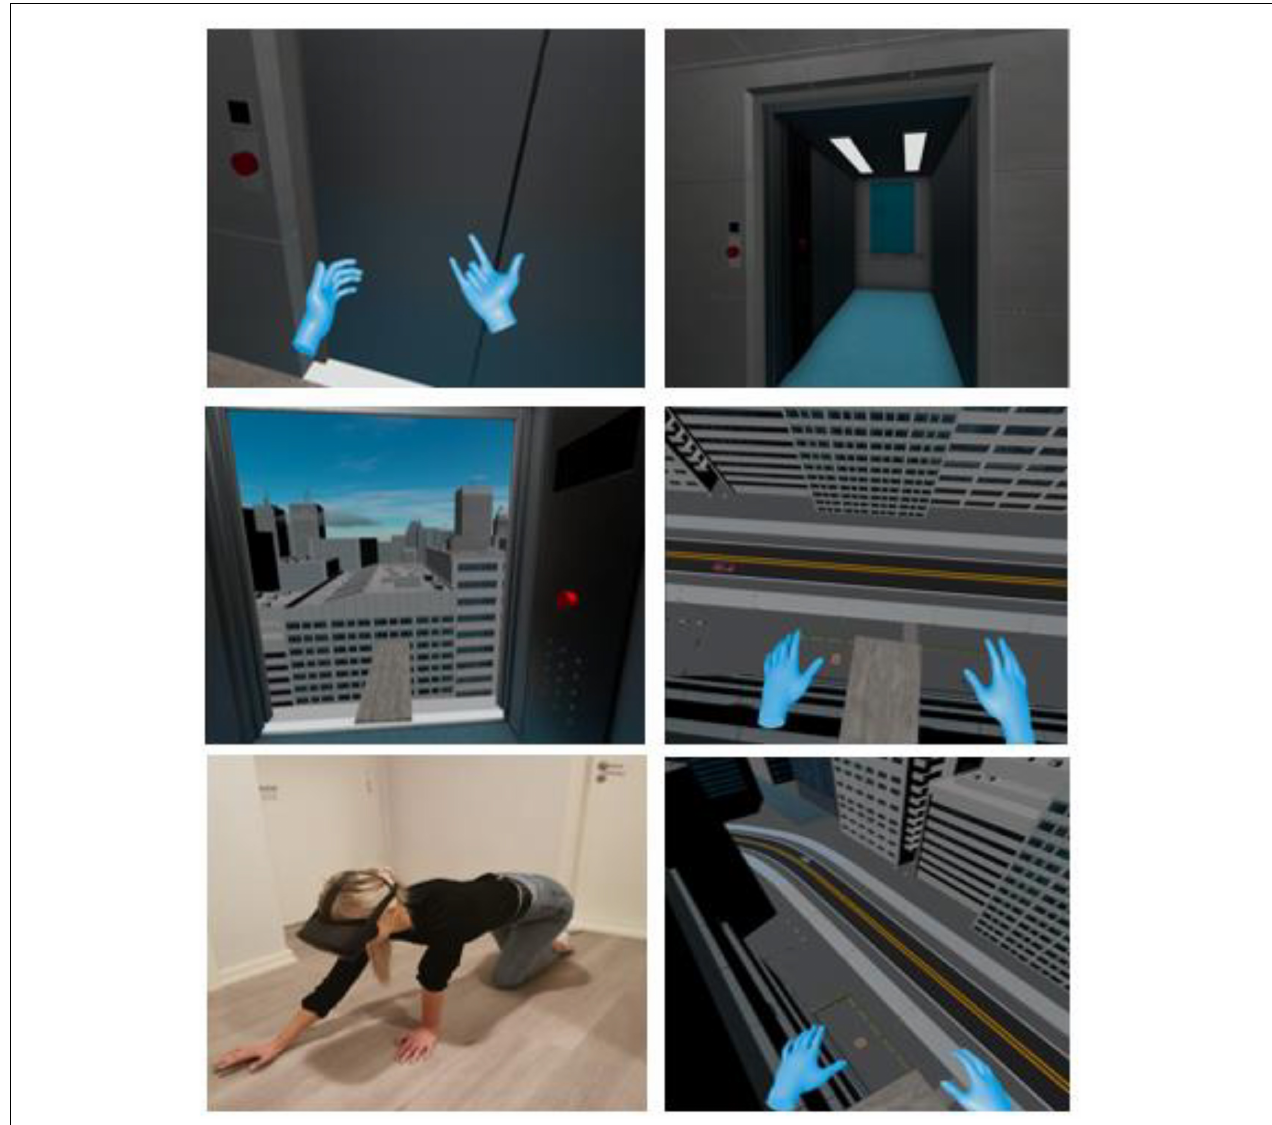
FIGURE 2 | Inner and outer perspectives of the plank-intervention.